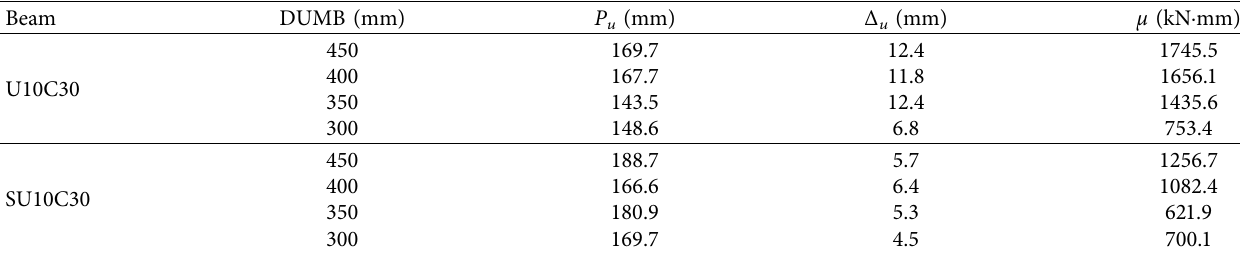
Table 4: Ultimate load, ultimate deflection, and MOT value of beams U10C30 and SU10C30 with different DUMBs. Beam